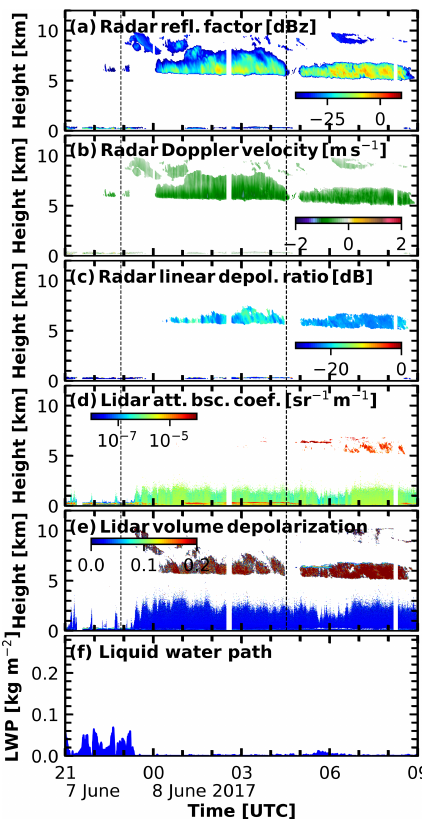
Figure 14. Same as Fig. 10 but for 7 June 2017 21:00UTC–8 June 2017 09:00UTC (note: the first and last launch shown in Fig. 15 was before the plotted profiles of the measurements